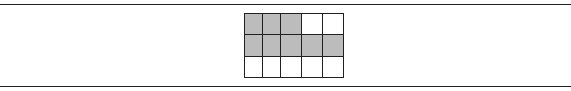
FIGURE 6: L34’s illustration for Question 1.3(a).